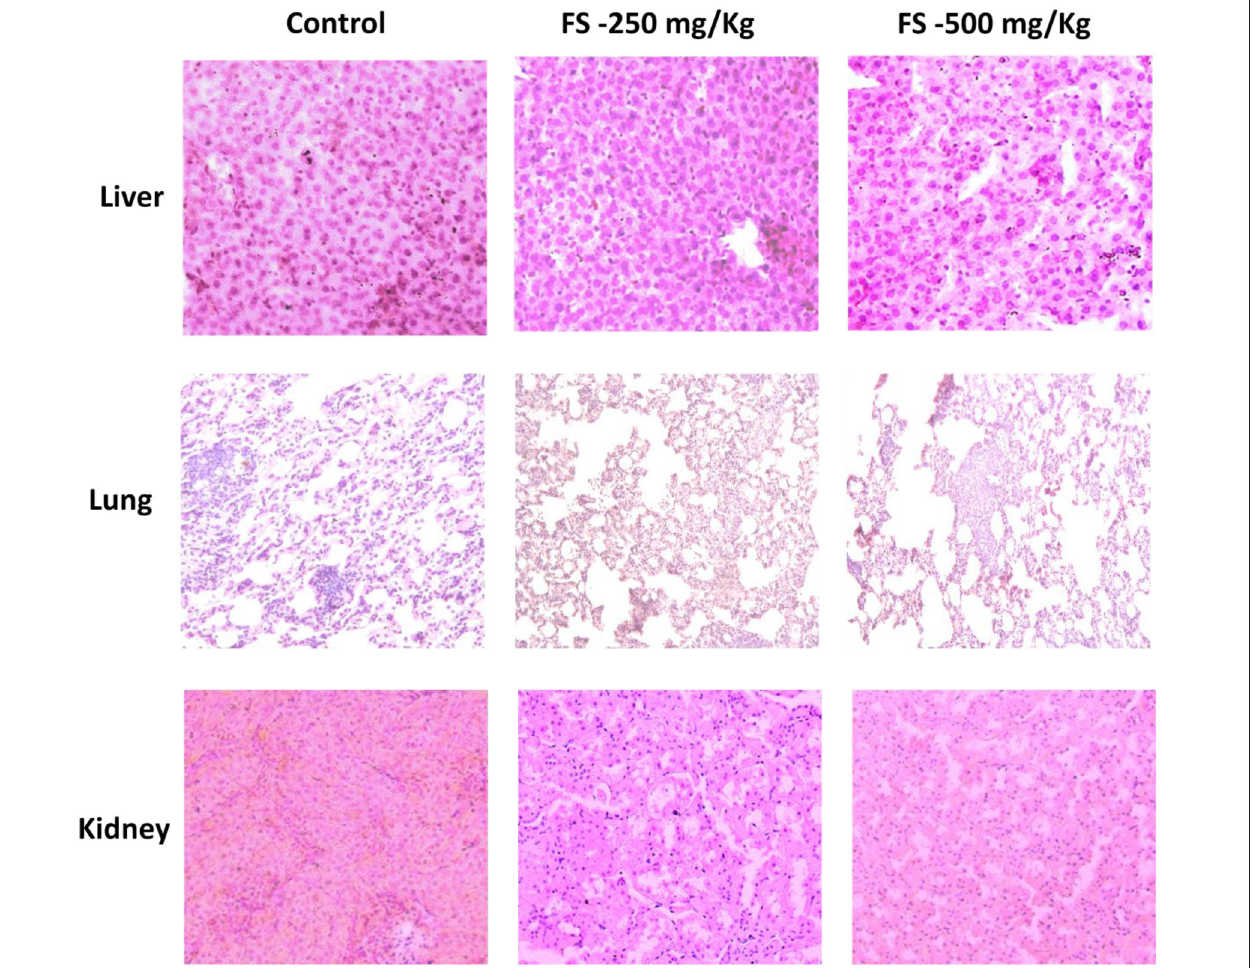
FIGURE 1 | Hematoxylin–eosin-stained photomicrographs of liver, lung, and kidney tissues of Wistar rats that were administered with 250 or 500 mg/kg of fungal taxol during the sub-acute toxicity study.